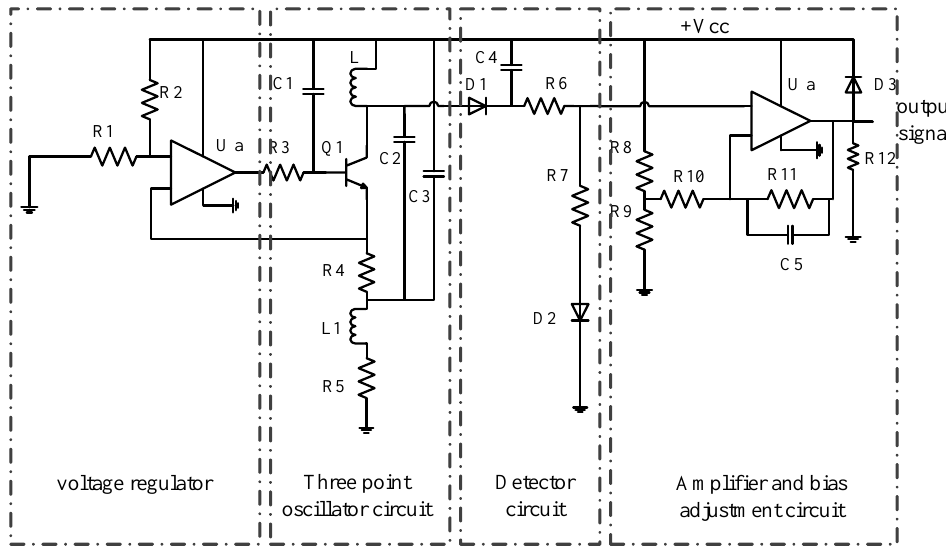
Figure 4. The measuring circuit of the SECS.